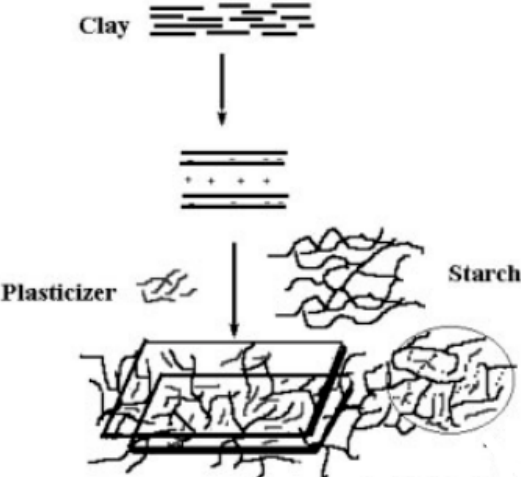
Figure 1. Representation of interactions between plasticizer and starch during migration towards clay galleries (Reproduced with permission [27]).